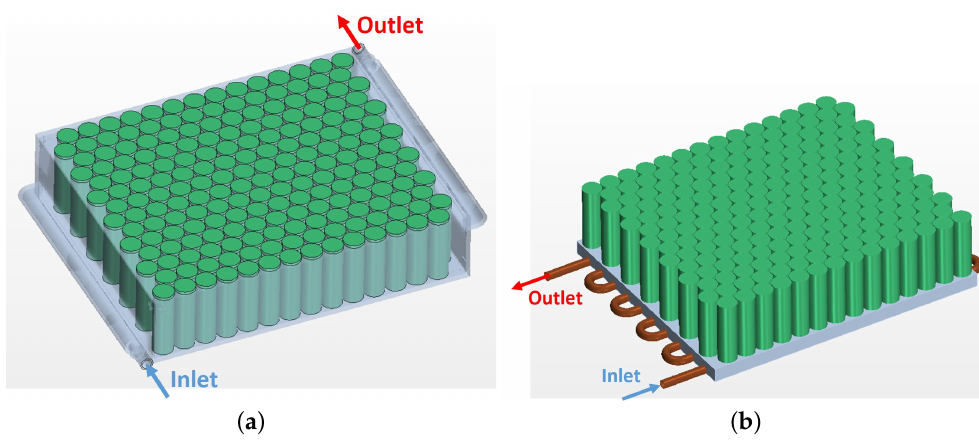
Figure 1. CAD model employed for the numerical simulations of ( a ) immersion cooling, and ( b ) cold- plate cooling.